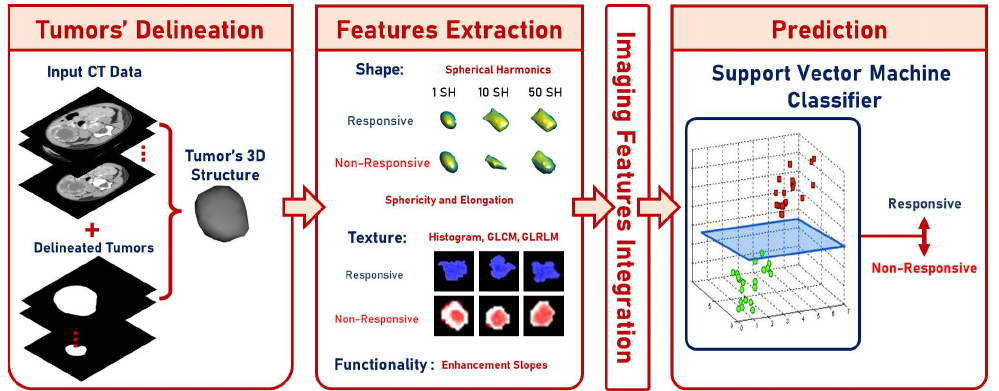
Figure 1. Graphical presentation of the suggested